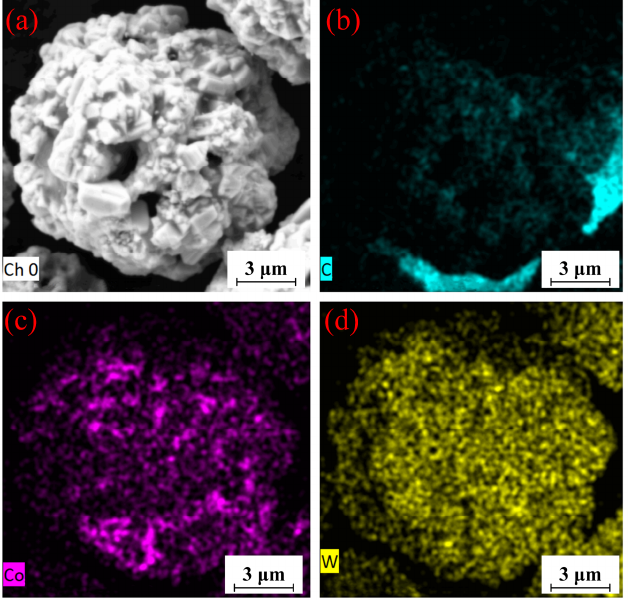
Figure 8. EDS maps of WC-12Co powder. ( a ) Plane scanned position; ( b ) C content; ( c ), Co content; (d), W content